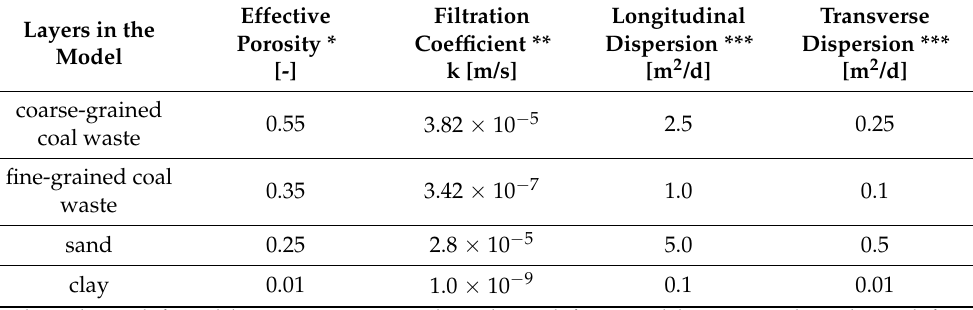
Table 2. The hydrogeological parameters used in the large and detailed models.